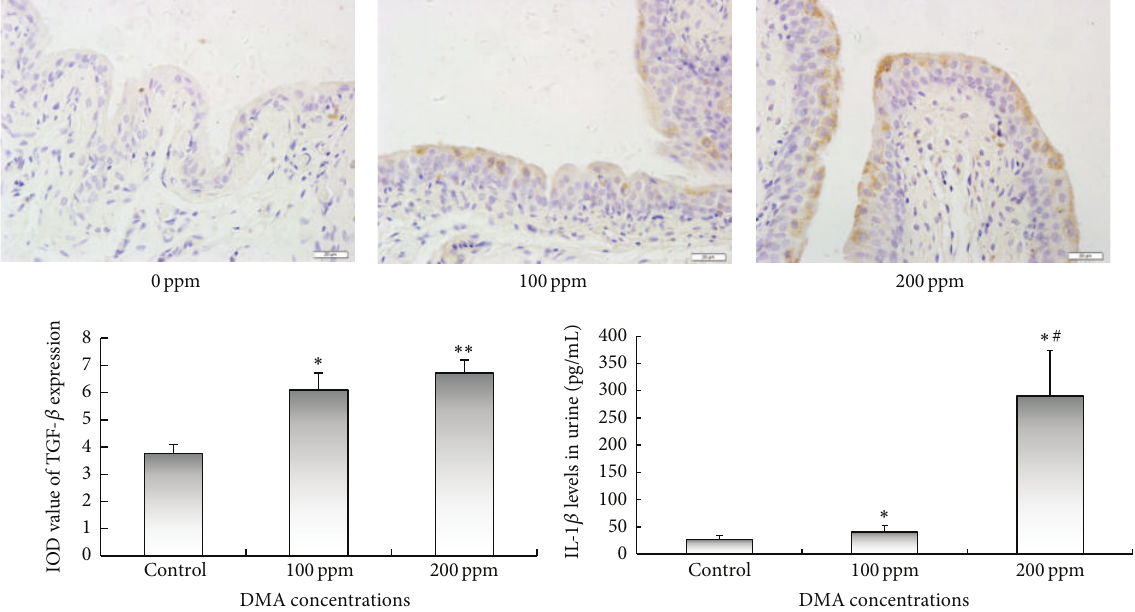
Figure 7: TGF- 𝛽 immunohistochemical staining of bladder epithelium and urinary IL-1 𝛽 levels in DMA V treated rats. TGF- 𝛽 expressions were presented in brown in cytoplasm. The panel was a graphical representation of the immunointensities of TGF- 𝛽 . The concentrations of IL-1 𝛽 in urine were measured by ELISA kits and bars were presented as mean ± SD. ∗ 𝑝 < 0.05 and ∗∗ 𝑝 < 0.01 compared to the control